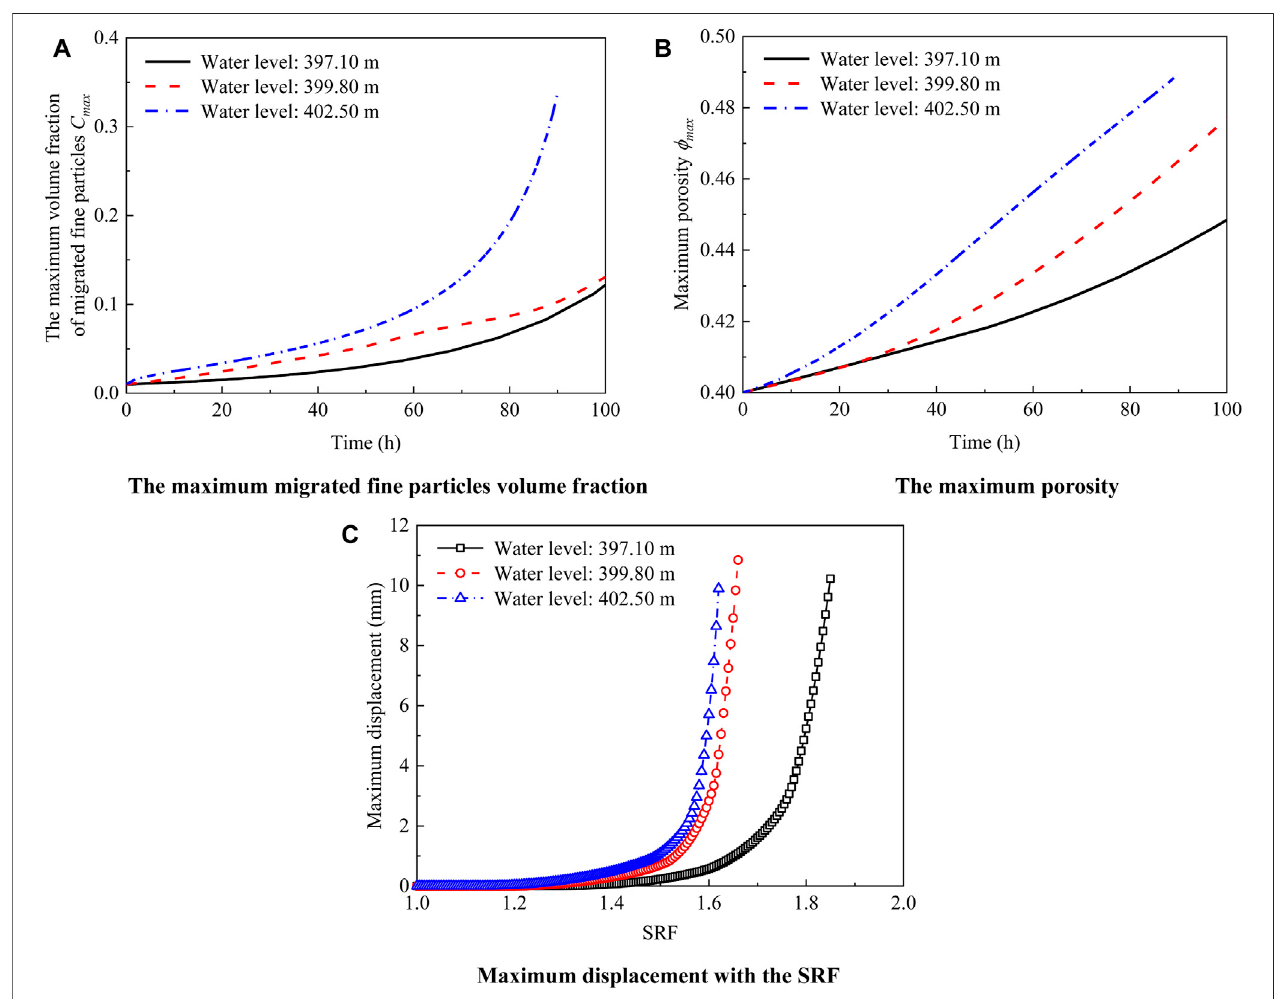
FIGURE 13 | The in fl uence of the water level on the maximum migrated fi ne particles volume fraction, maximum porosity, and maximum displacement. (A) The maximum migrated fi ne particles volume fraction. (B) The maximum porosity. (C) Maximum displacement with the SRF.